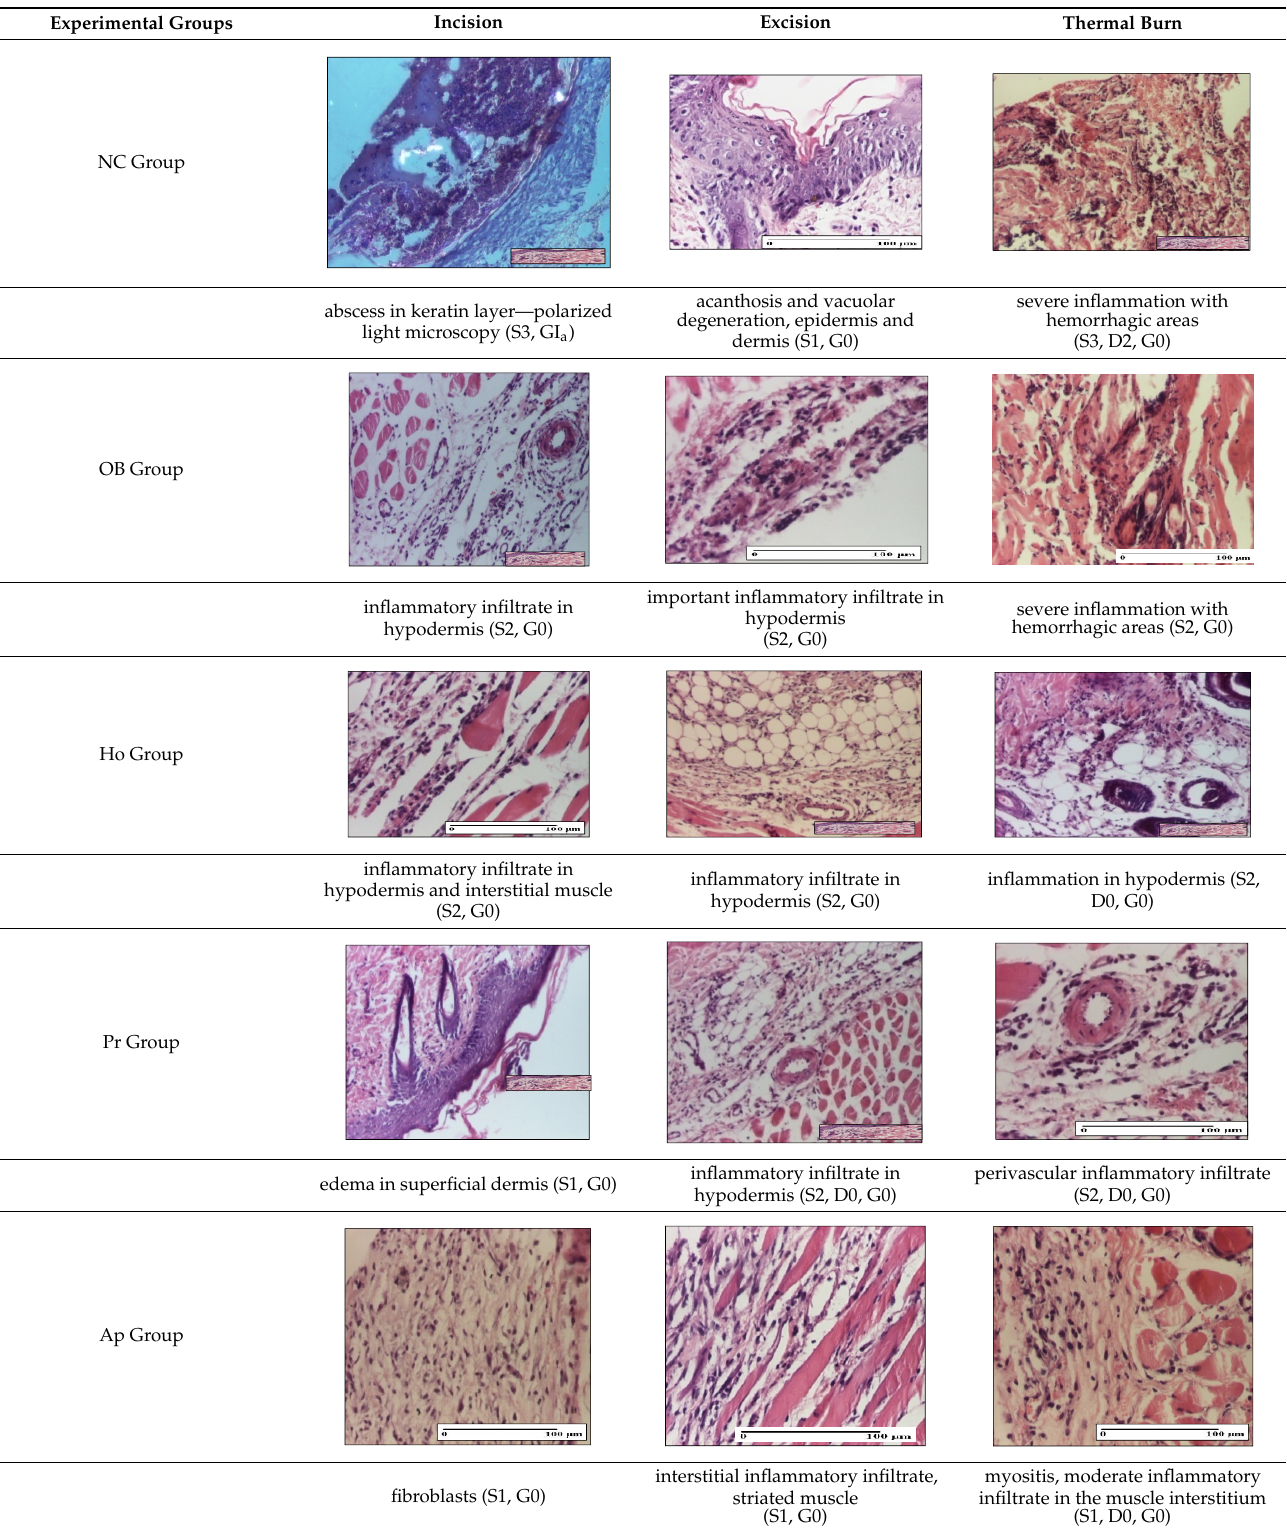
Table 4. Histopathological evaluation of the tissue samples on day 3.